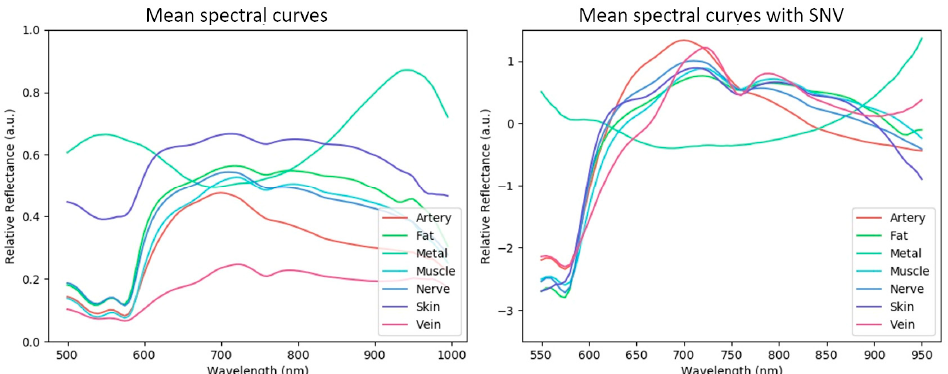
Figure 3. Mean spectral curves of all classes overlaid in a single plot ( left without SNV, right with SNV normalization).